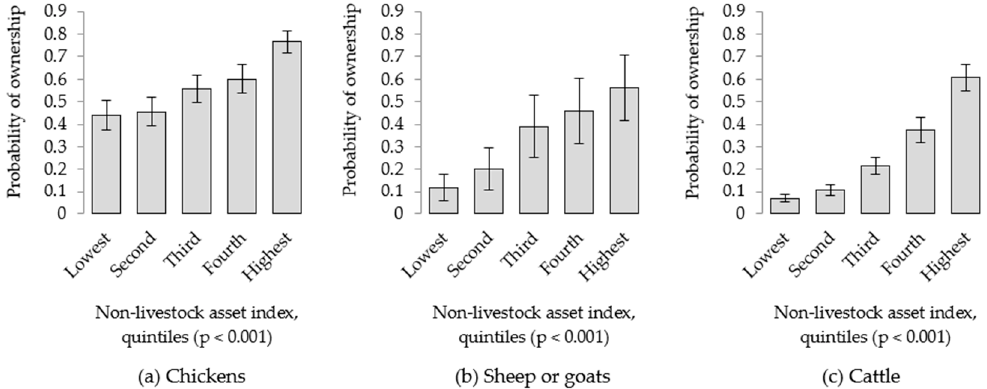
Figure 2. Probability of owning livestock, according to quintiles of the non-livestock asset index (NLAI). For all categories of animals—( a ) chickens, ( b ) sheep and goats, and ( c ) cattle—the NLAI was positively associated with the probability of ownership ( p < 0.001). Standard errors are shown.